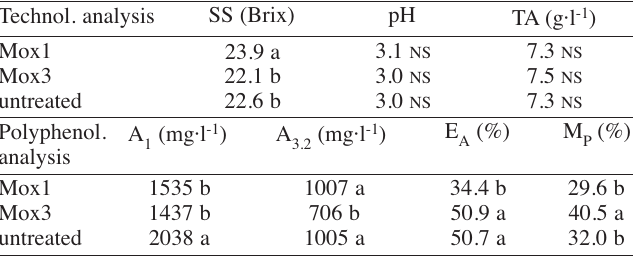
Table 3 - Berry soluble solids (SS), pH, titratable acidity (TA), berry Glories indices (A 1 : total anthocyanins; A 3.2 :